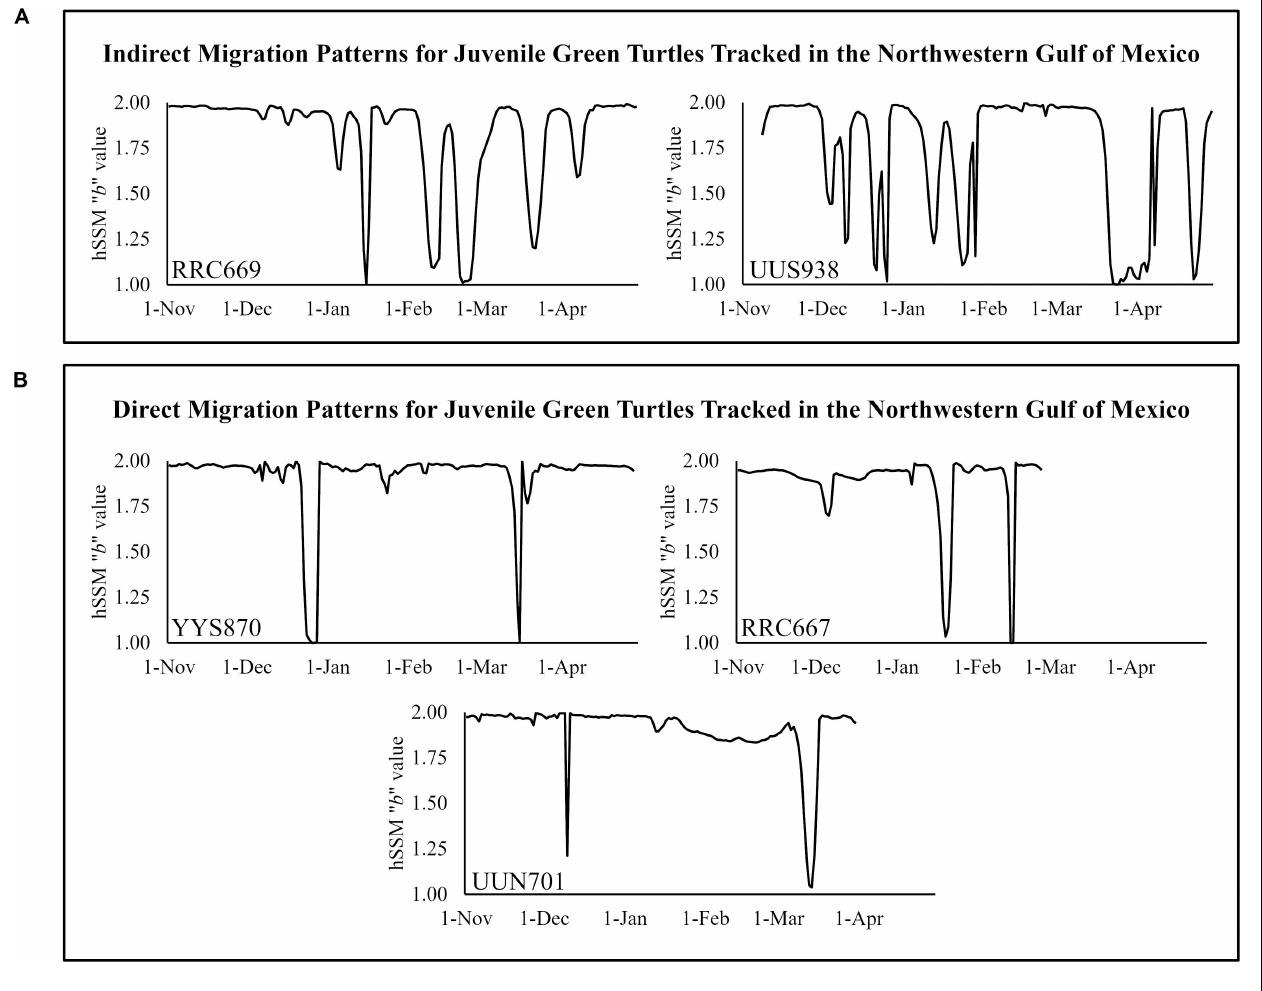
FIGURE 3 | Migration patterns for juvenile green turtles satellite tracked in the northwestern Gulf of Mexico ( n = 5). hSSM “b” values > 1.5 are representative of foraging/residency behavior, while values < 1.5 are representative of migratory behavior. (A) “Indirect” migratory pattern characterized by multiple alternations between migration and short-term residency prior to establishment of overwintering residency in Mexican waters. (B) “Direct” migratory pattern characterized by unidirectional short migration period and prolonged overwintering residency prior to summer remigration back to United States waters.